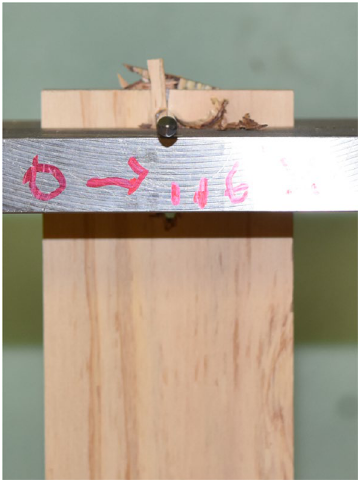
Fig. 4 End shear failure (ESF). The parameters were as follows: panel type, PW-s; d , 5.2 mm; ph , 0; dowel position,